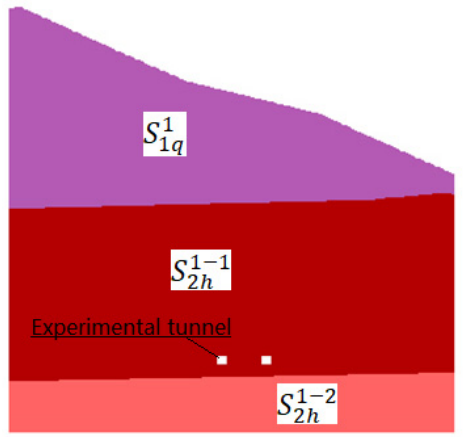
Figure 15. The geology map of the Goupitan experimental tunnel.